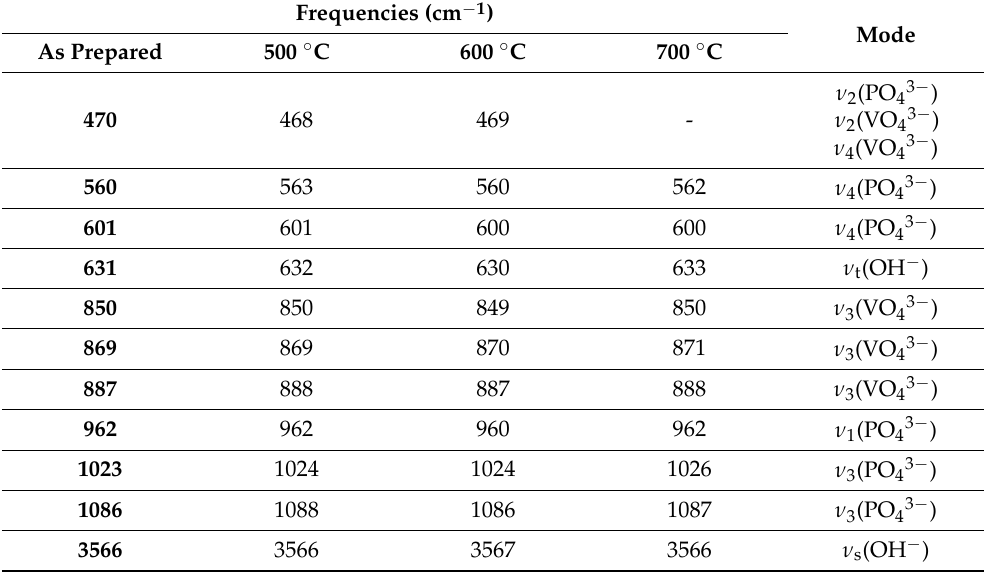
Table 2. Band frequencies and assignment for the ATR-FT-IR spectra of HVp co-doped with 1 mol% Sr 2+ and 1 mol% Tb 3+ ions: samples thermally untreated (as prepared) and annealed at 500, 600 and 700 ◦